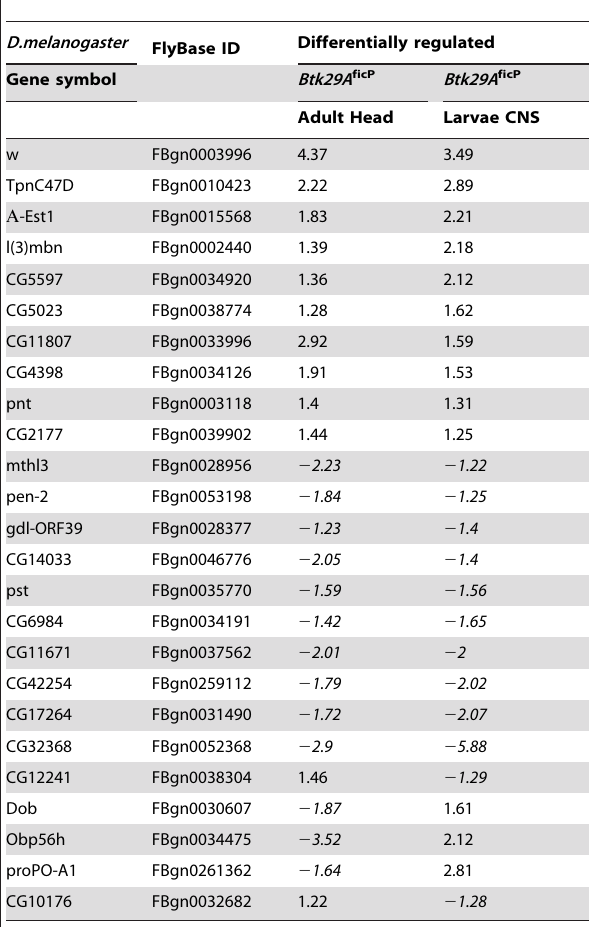
Table 1. 25 genes found to overlap between D. melanogaster larvae CNS and adult